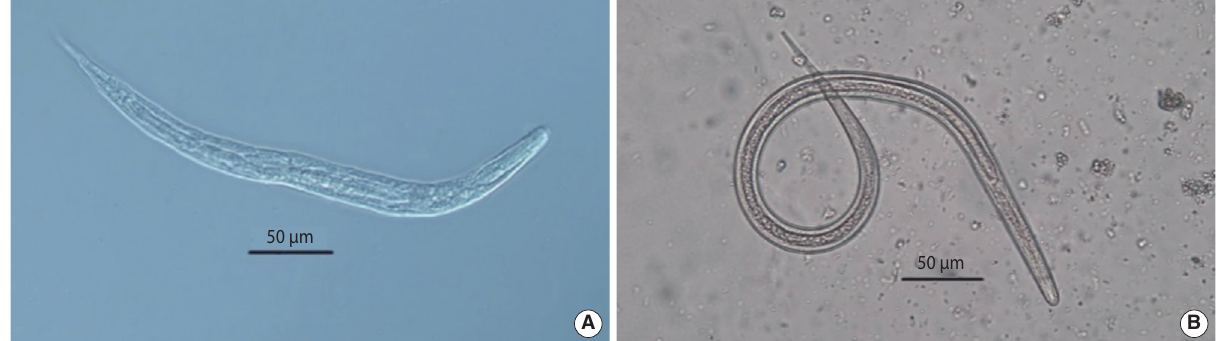
Figure 2. Rhabditiform (A) and filariform (B) larvae of Strongyloides stercoralis obtained through agar plate culture. Table 3. Prevalence of infections with Strongyloides stercoralis in patients receiving immunosuppressive drugs in Guilan Province, northern Iran, according to demographic factors